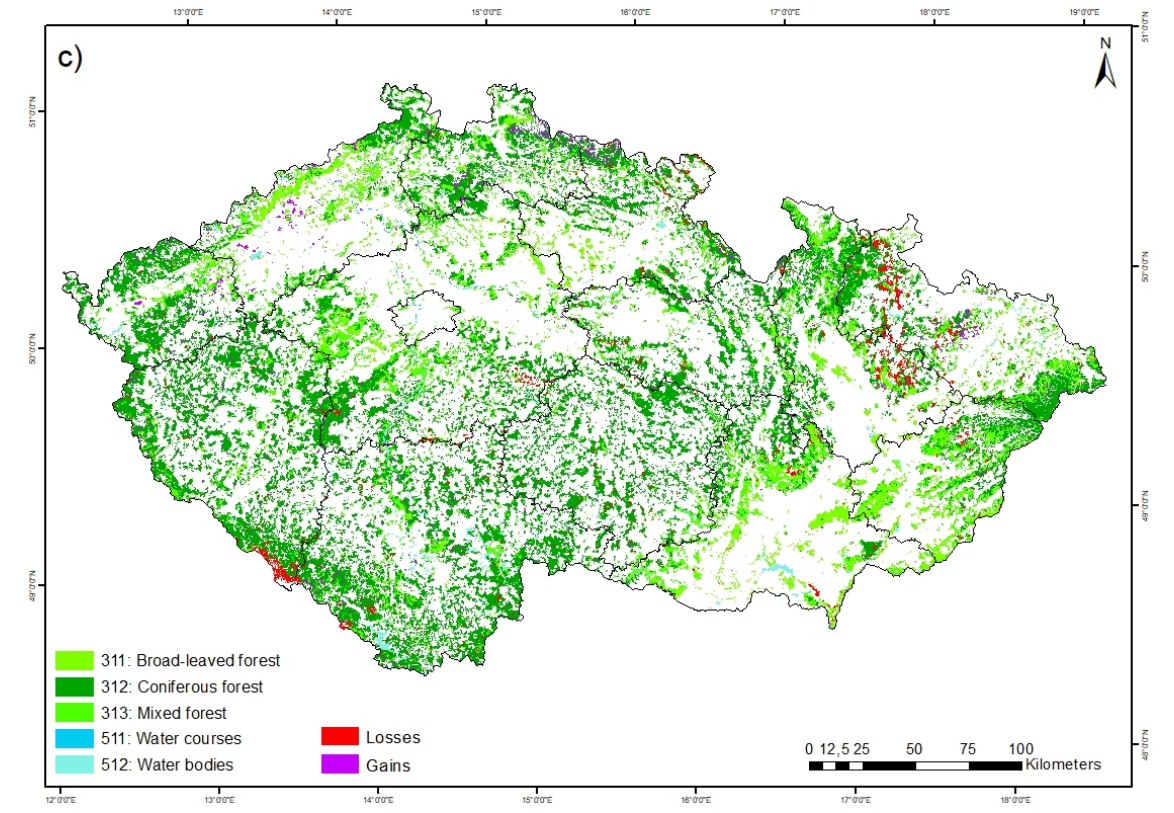
Figure 3. Geospatial representation of forest cover and water body area change in the Czech Republic. ( a ) 1990–2006; ( b ) 1990–2018; ( c ) 2006–2018.